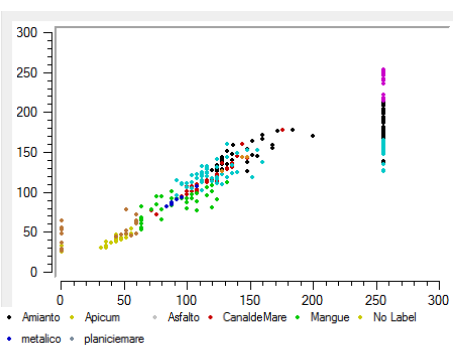
Figure 8: Exploratory analysis using a decision tree.